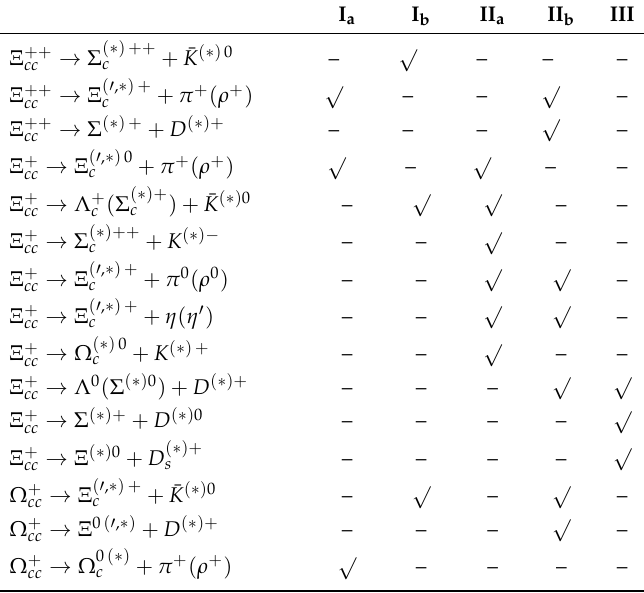
Table 3. Classification of the Cabibbo-favored nonleptonic two-body decays of the ground state double charm